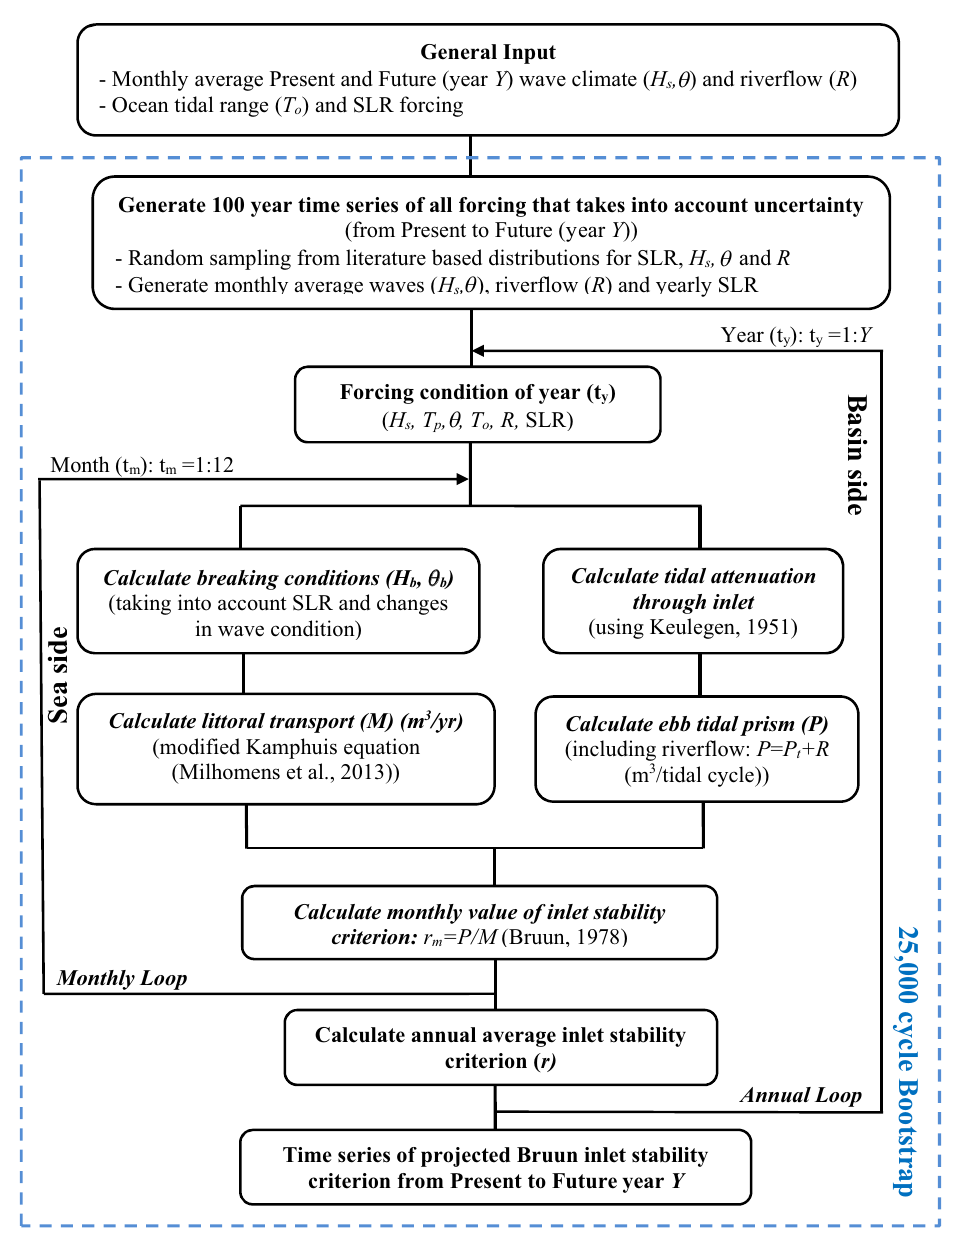
Figure 1. Basic structure of RAPSTA. Y: index of future year from present year, t y : year index in the range [1- Y ] in the annual loop,